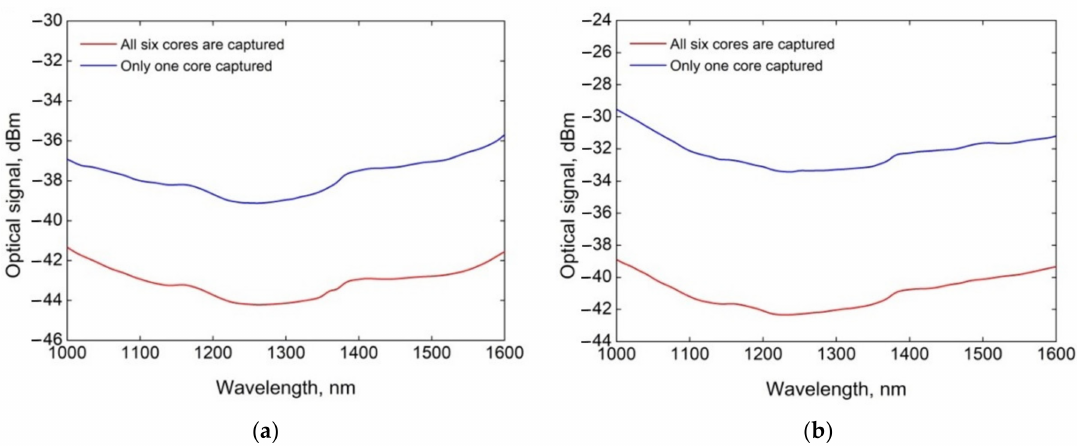
Figure 12. Transmission spectra of six-core-MOFs with graded-index core supporting elements: ( a ) MOF with twisting 400 rpm; ( b ) MOF with twisting 500 rpm.